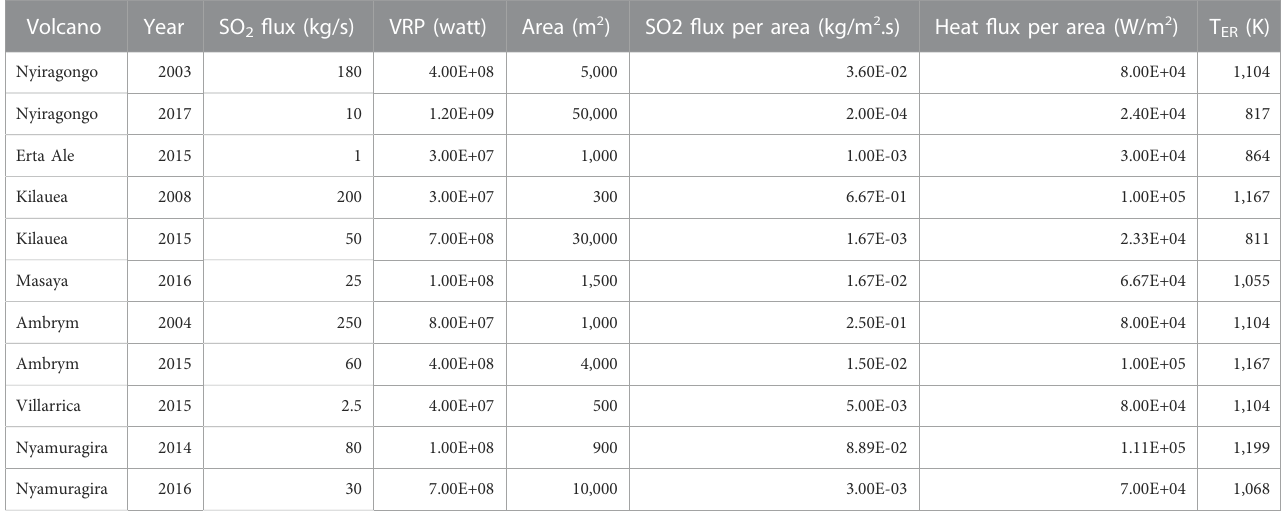
TABLE 1Maincharacteristicsofthe lavalakes atcertain stages of theirexistence. Area isestimated from the photographs shownpreviously, except for Villarrica taken from Moussallam et al. (2016) and Ambrym in 2004 (T. Dockx, Pers. Com.). Volcano